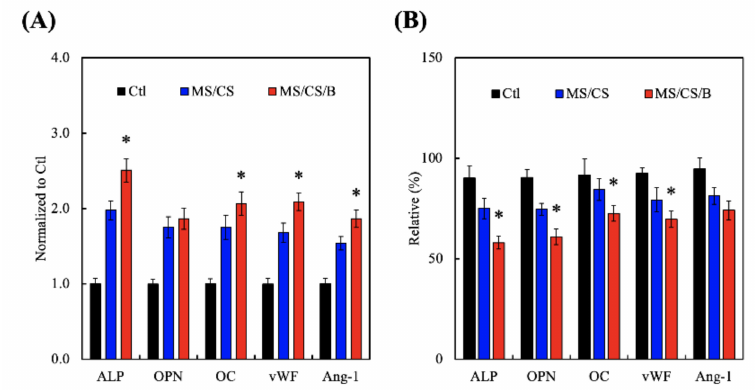
Figure 9. The osteogenic and angiogenic protein expression of ( A ) the hDPSCs and ( B ) the siRNA– BMPR2 transfected hDPSCs on scaffolds for 7 days. * indicates a significant difference ( p < 0.05) when compared to MS/CS.